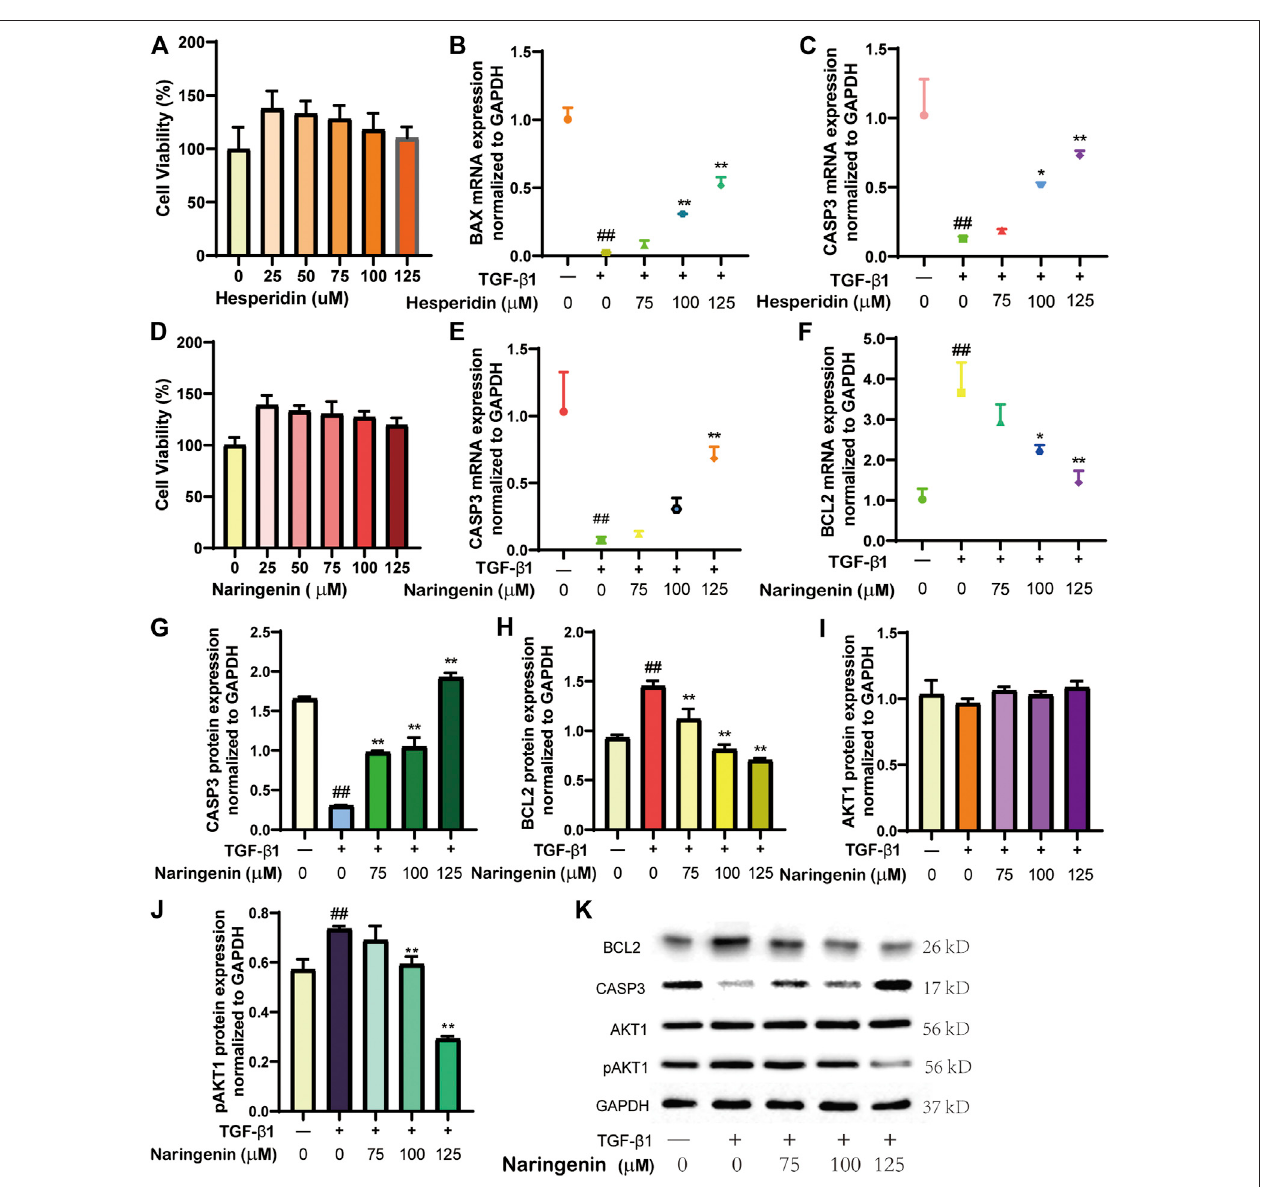
FIGURE 5 | Effect of hesperidin or naringenin on LX-2 cells. The effects of hesperidin (A) or naringenin (D) on LX-2 cell viability using the CCK-8 assay. mRNA expression of BAX (B) , CASP3 (C, E) , and BCL2 (F) were determined by qRT-PCR. Protein levels of CASP3 (G) , BCL2 (H) , AKT1 (I) , pAKT1 (J) were determined by western blot, with results of each group (K) . # p < 0.05, ## p < 0.01 versus blank control group; * p < 0.05, ** p < 0.01 vs. TGF- β 1-treated group.